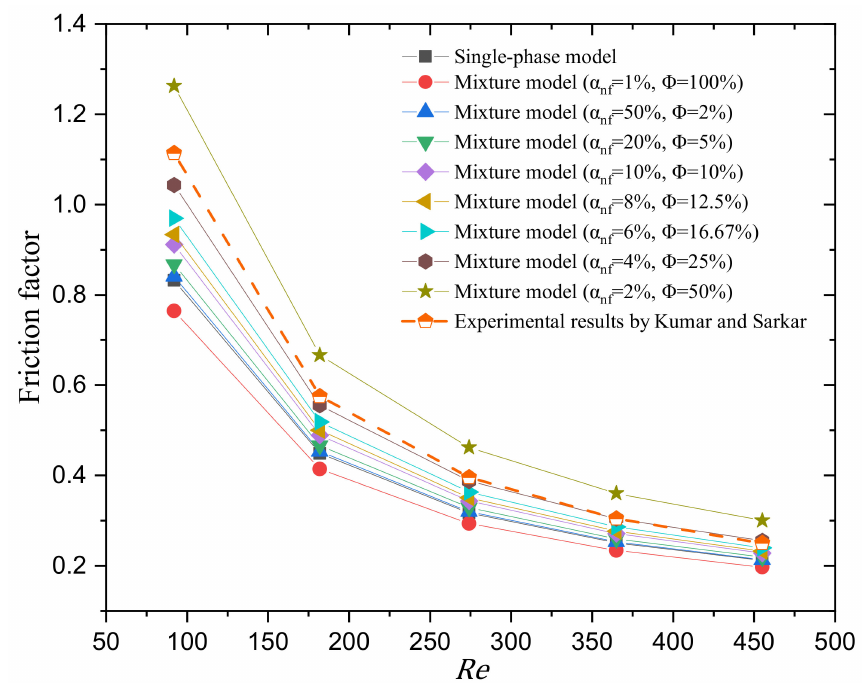
Figure 10. Friction factor along the minchannel predicted by the single-phase approach and by the two-phase mixture model at 92 ≤ Re ≤